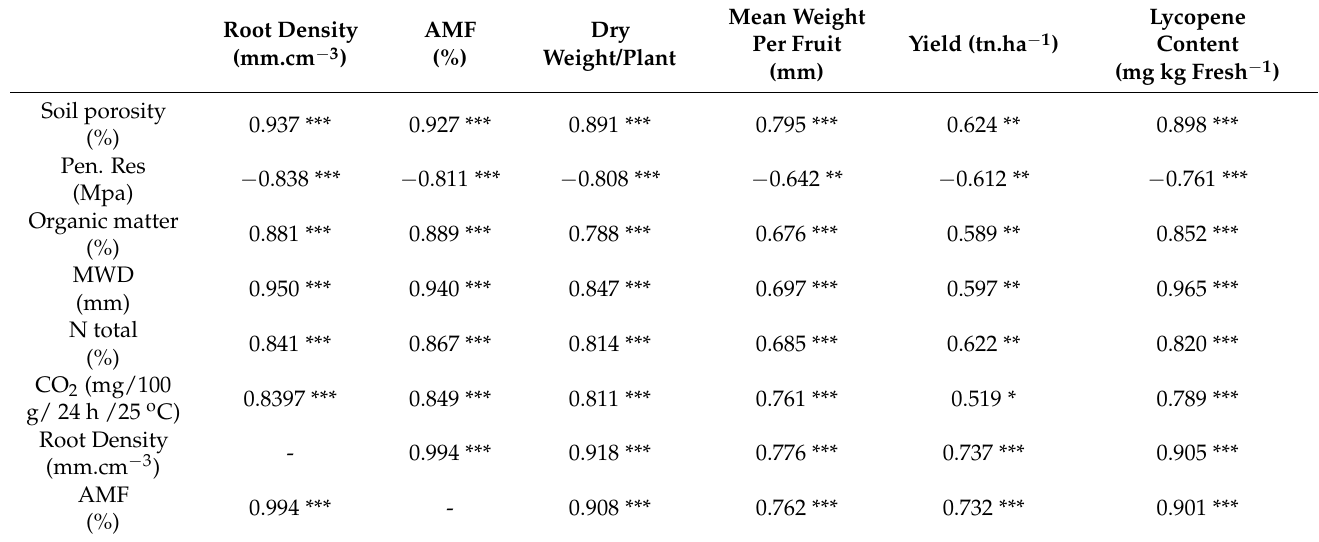
Table 5. Pearson’s correlation coefficient ( r ) between soil and agronomic